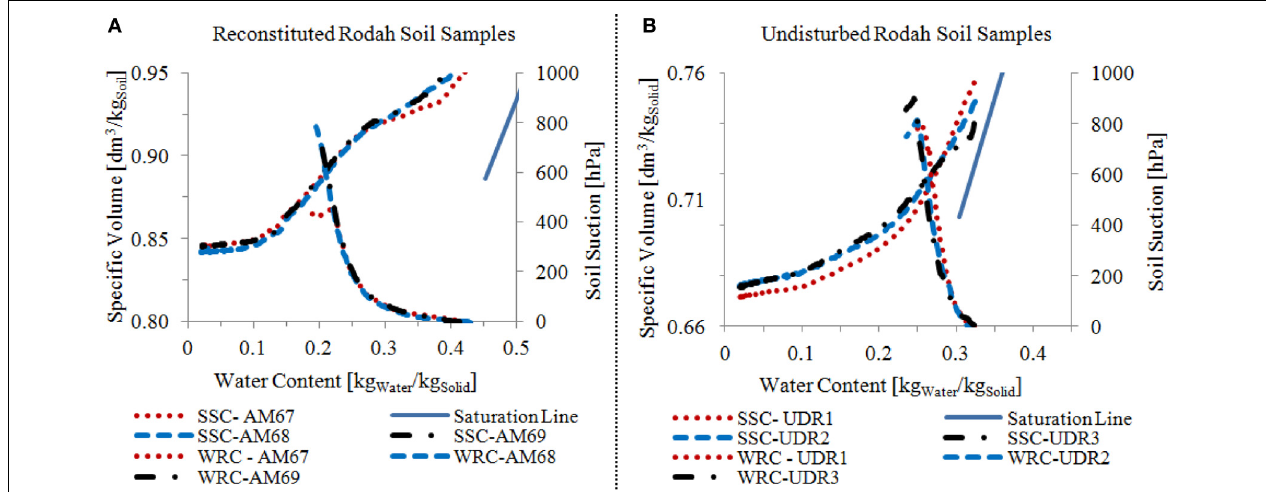
FIGURE 6 | The measured soil moisture characteristic curves for Rodah soil: Water Retention Curve [WRC] and Soil Shrinkage Curve [SSC] for (A) the three replicates of reconstituted Rodah soil samples (aggregate size: 200 μ m–2mm); (B) the three replicates of undisturbed Rodah soil samples.